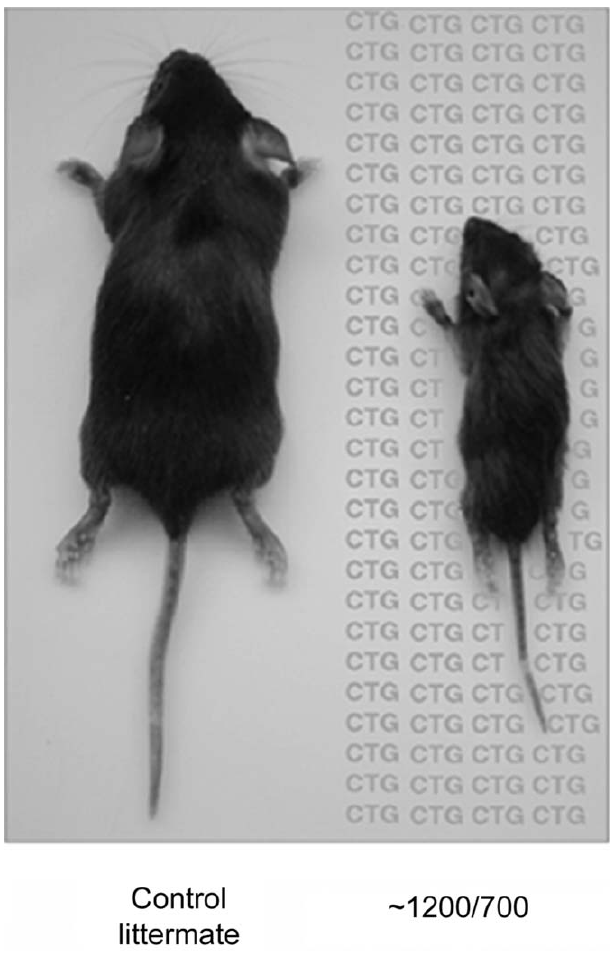
Figure 2. Body Size Reduction in Homozygous Mice Carrying Very Large CTG Repeat Expansions on Both Alleles Marked growth retardation in a 4-wk-old homozygous mouse carrying ; 1,230 and ; 700 CTG repeats compared to a control